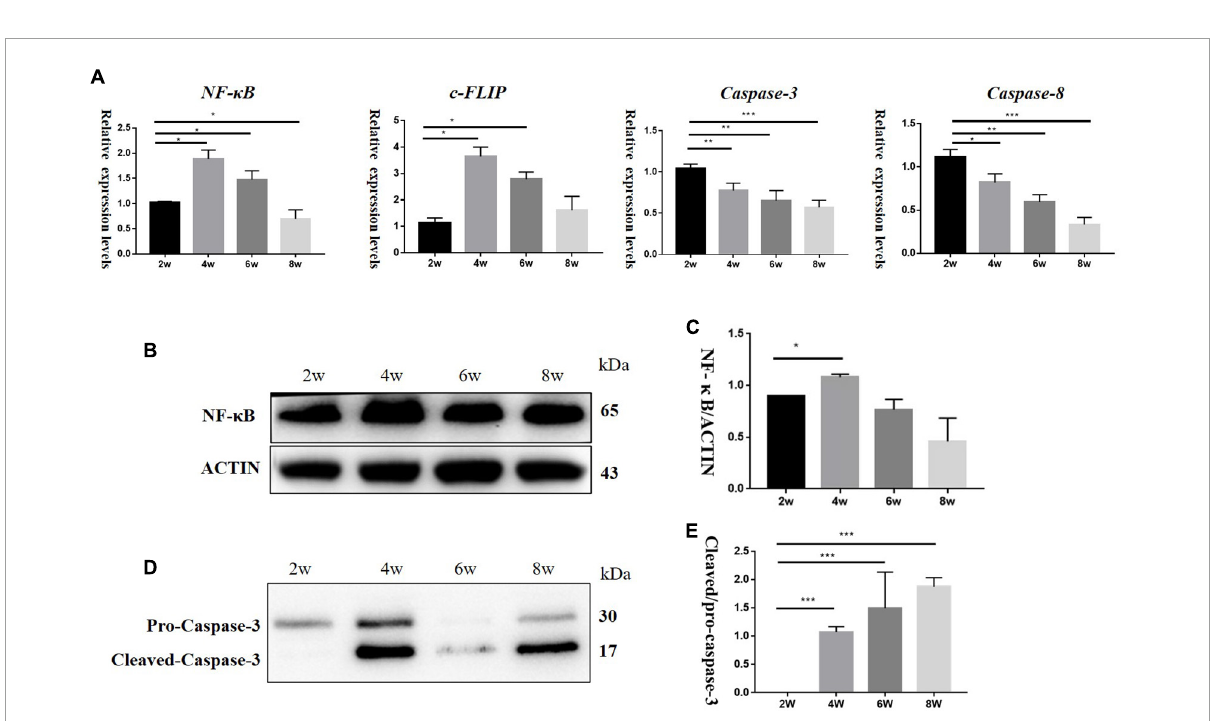
FIGURE4 (A) It showed mRNA relative expression levels of Nf-kb , C-flip , Casp3 , and Casp8 in DBA/2J mice at 2,4, 6, and 8 weeks of age. (B,D) Protein levels of NF- κ B and Caspase-3 in DBA/2J mice aged 2, 4, 6, and 8 weeks. (C,E) Semi-quantitative analysis of NF- κ B and Caspase-3 protein levels (* P < 0.05, ** P < 0.01, *** P <